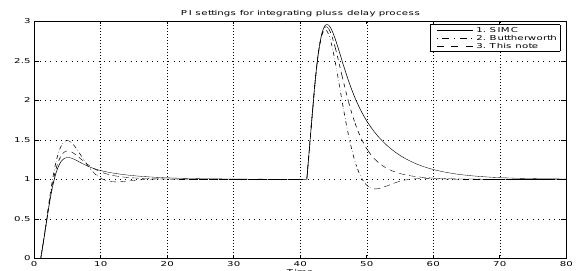
Figure 2: PI control of integrating plus delay pro-